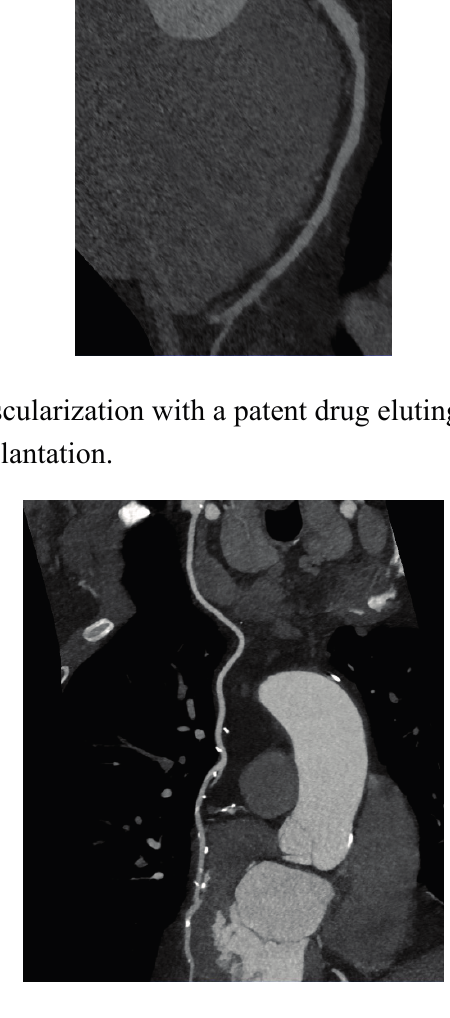
Figure 4. Patent right mammary artery bypass graft (free transplant with end-to-side anastomosis on left mammary artery) with anastomosis on obtuse marginal